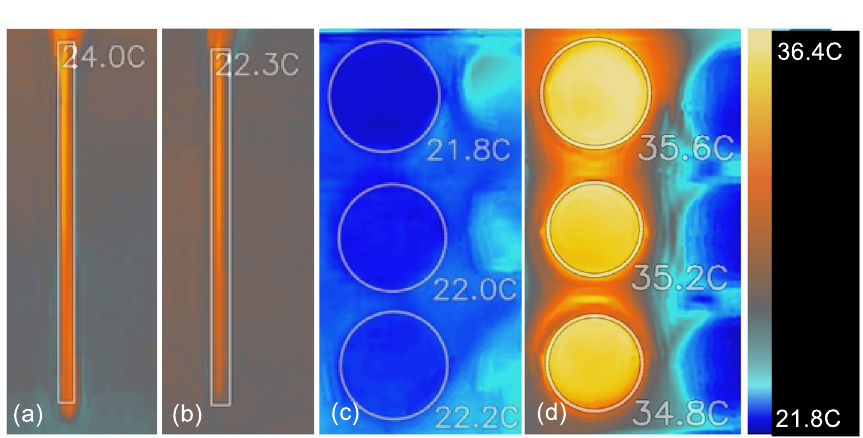
Figure 11. Representative temperature from IR thermal imaging of: ( a ) ns-DBD + exposed electrode, ( b ) − ns-DBD exposed electrode, ( c ) samples before plasma treatment, and ( d ) samples during plasma treatment.